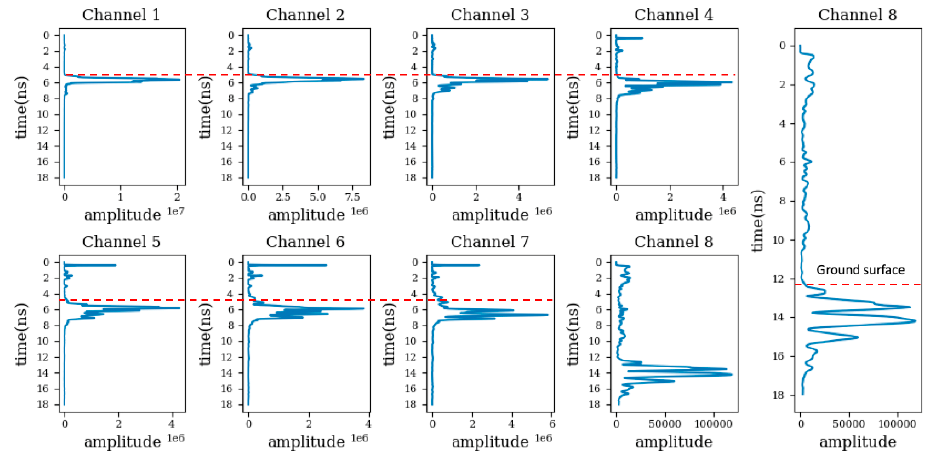
Figure 7. Radargrams from all 8 channels. Observed time delay in channels 1 to 7 is approximately uniform, while there is a consistent, excessive time delay observed in channel 8, which might be due to some element of ground-wave arrival in the path of its antenna pair.